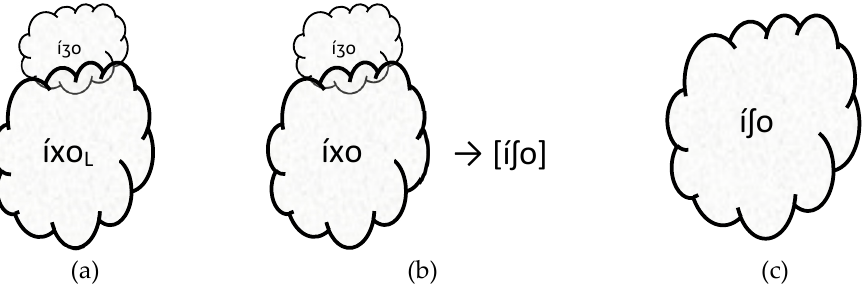
Figure 5. Hypothesized pathway of change in a South Floridian JS idiolect for the lexeme ‘son’ ( a ), involving the removal of the L diacritic from the label of the loanword exemplar subcloud ( b ) and the eventual relabeling of a single exemplar cloud ( c ).